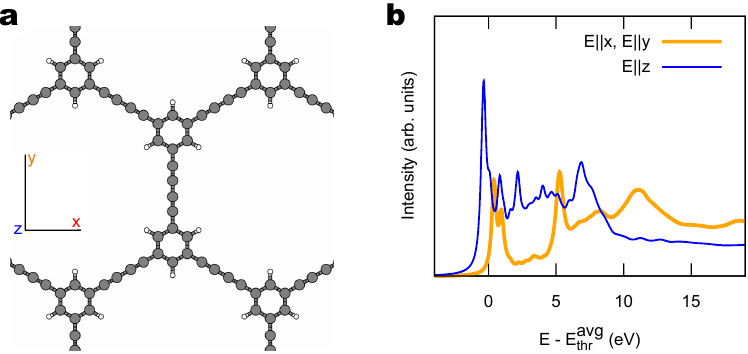
Figure 8. ( a ) Structural model of 2D network formed by de-bromination of tBEP/Au(111) [30] (here simulated as if it were freestanding). ( b ) Simulated NEXAFS spectrum for in-plane ( x , y ) and out-of-plane ( z ) photon